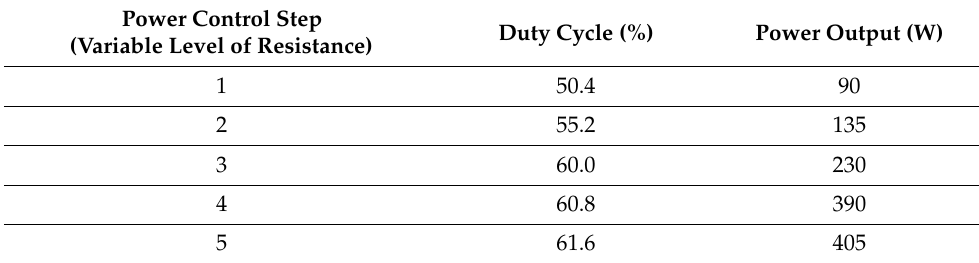
Table 3. The relationship between the step of the variable resistor, duty cycle of the transformer input voltage, and the microwave power